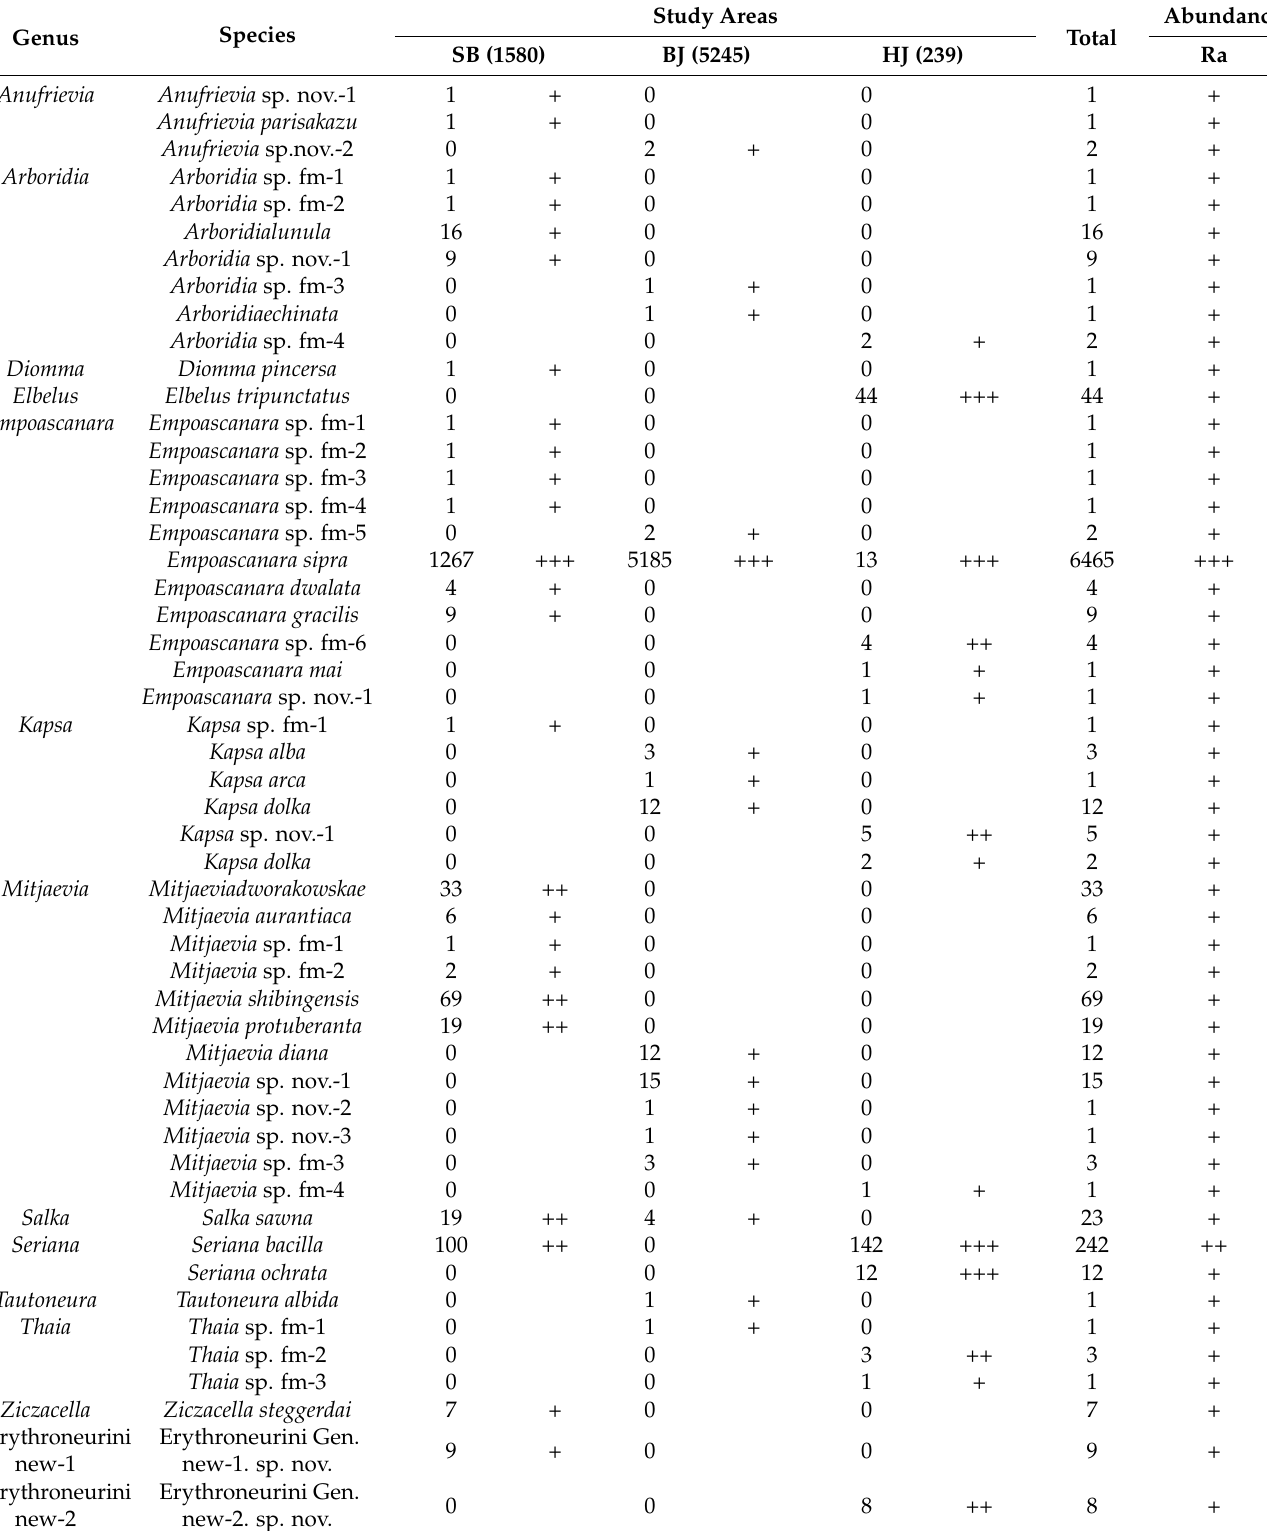
Table 1. Community structure of Erythroneurine leafhoppers in the study